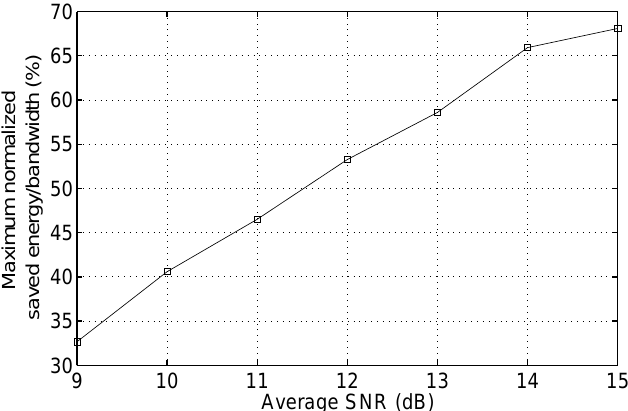
Figure 10. Maximum allowed SNR threshold ( γ ∗ the average SNR ( ¯ γ ). Rayleigh fading channel, N = 10 .